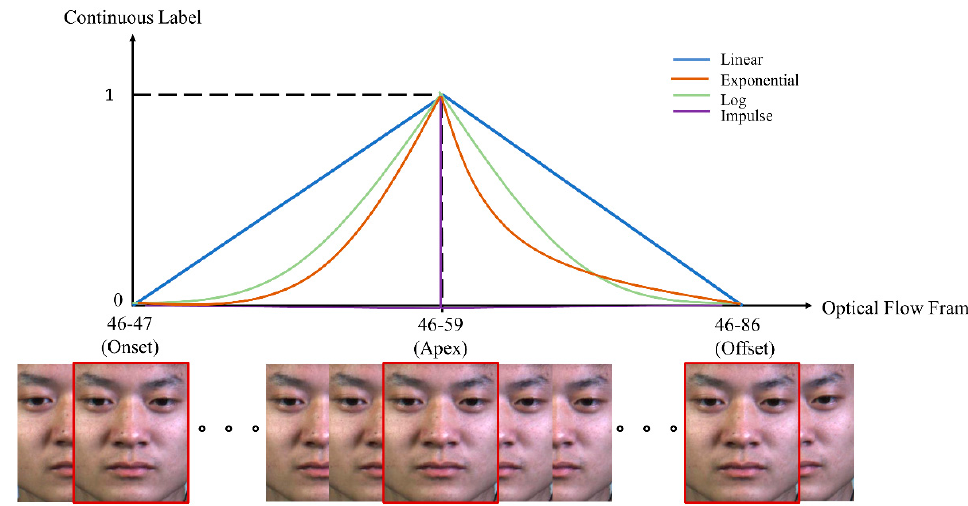
Figure 6. Continuous labeling scheme for the ME using optical flow input.